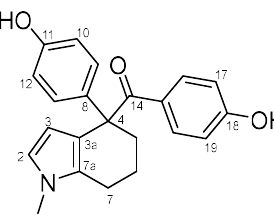
Scheme 18. Structure of 31a with the numbering of atoms used for the assignment of NMR